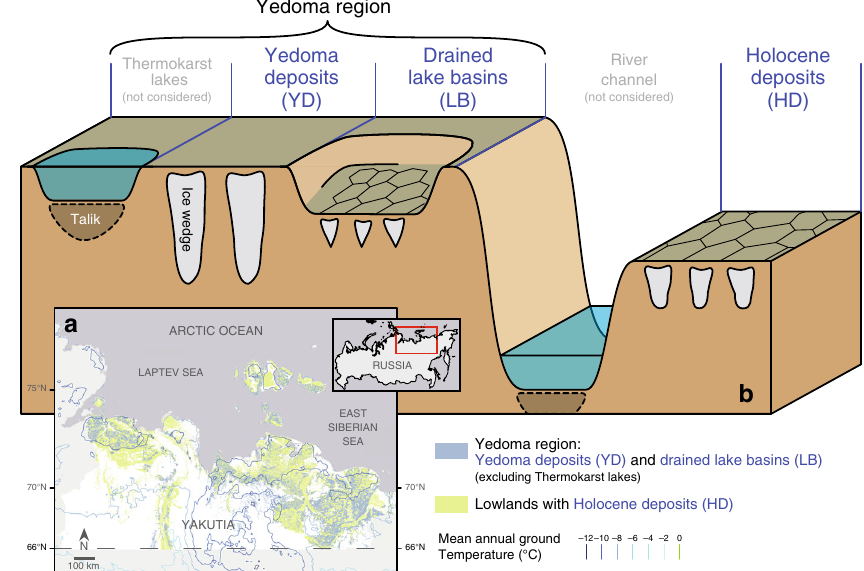
Fig. 1 Map and schematic of ice-rich permafrost landscapes. a Map showing the extent of ice-rich lowlands and mean annual ground temperatures 30 in northeast Siberia. See Supplementary Fig. 2 for an enlarged map of the study region. b Climate-driven landscape evolution during the last glacial period and the Holocene has led to diverse types of ice-rich permafrost landscapes. At present, ice wedges are the most common form of excess ground ice, but there is large variability in the volume and thickness of wedge ice. We assumed ice wedges to increase in lateral size and depth from drained lake basins (LB), over Holocene deposits (HD), to undisturbed Yedoma deposits (YD). While LB and HD feature active ice-wedge polygons with a patterned surface microtopography, YD host relict ice-wedge polygons which are covered by younger deposits. Note that we excluded from our analysis old thermokarst lakes and large water bodies already existing in the study region. See Supplementary Fig. 1 for an extended version of the